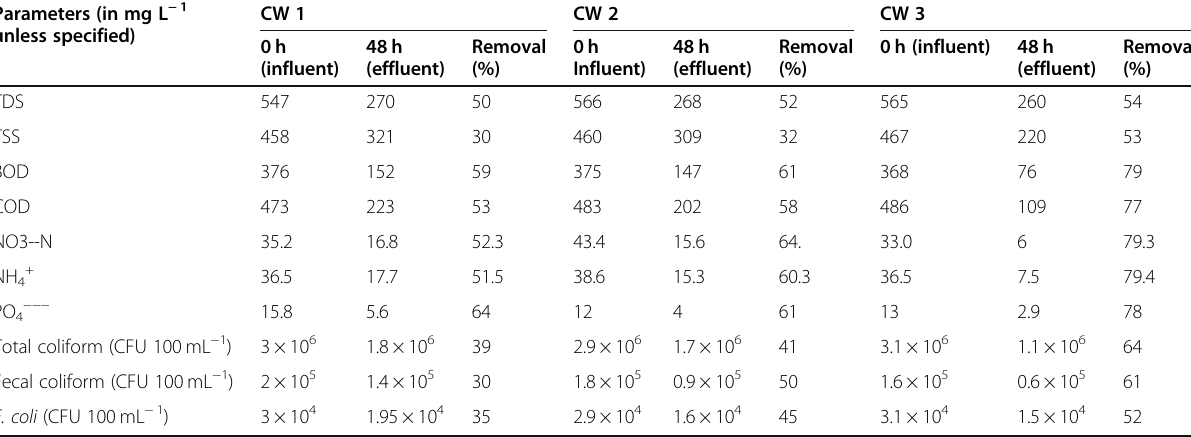
Table 2 Removal of physicochemical and biological parameters of primary treated sewage through constructed wetlands (CW 1, CW 2 and CW 3) Parameters (in mg L −